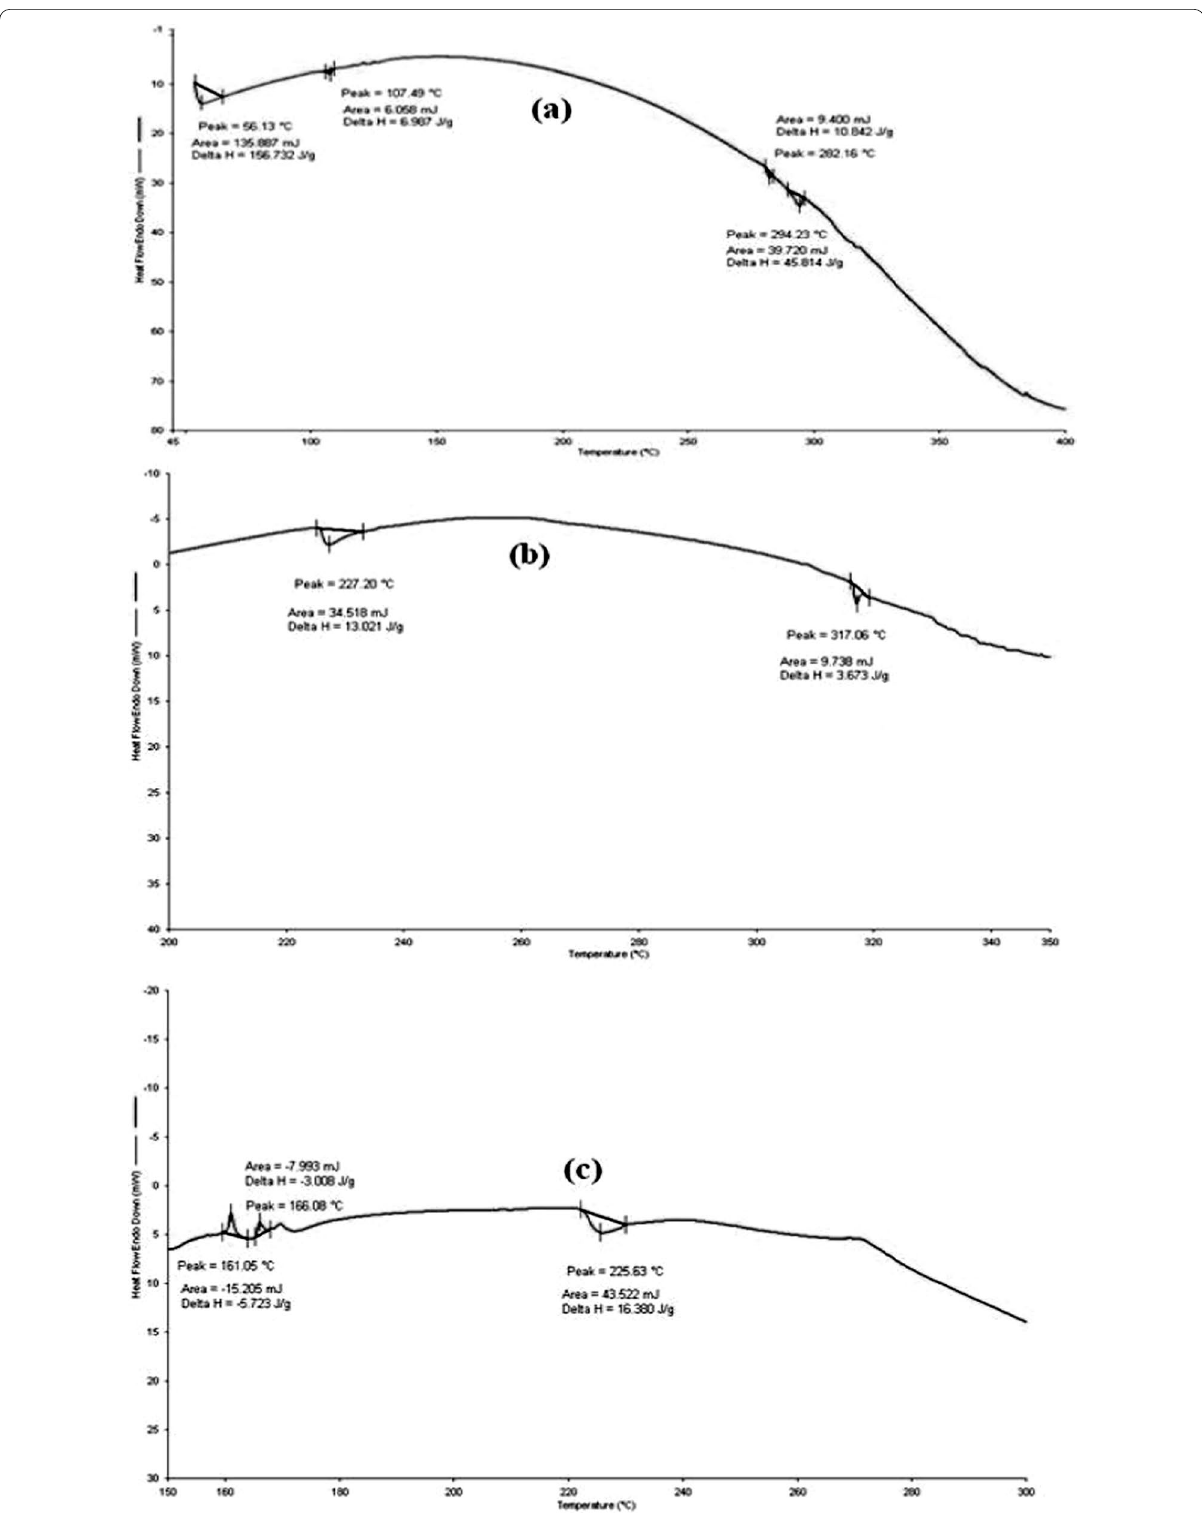
Fig. 4 DSC thermograms of pure Diclofenac sodium ( a ), P4 chitosan–Gellan gum–Gum Ghatti PEC beads containing Diclofenac sodium ( b ) and P6 Chitosan–Gellan Gum–Gum Karaya PEC beads containing Diclofenac sodium ( c